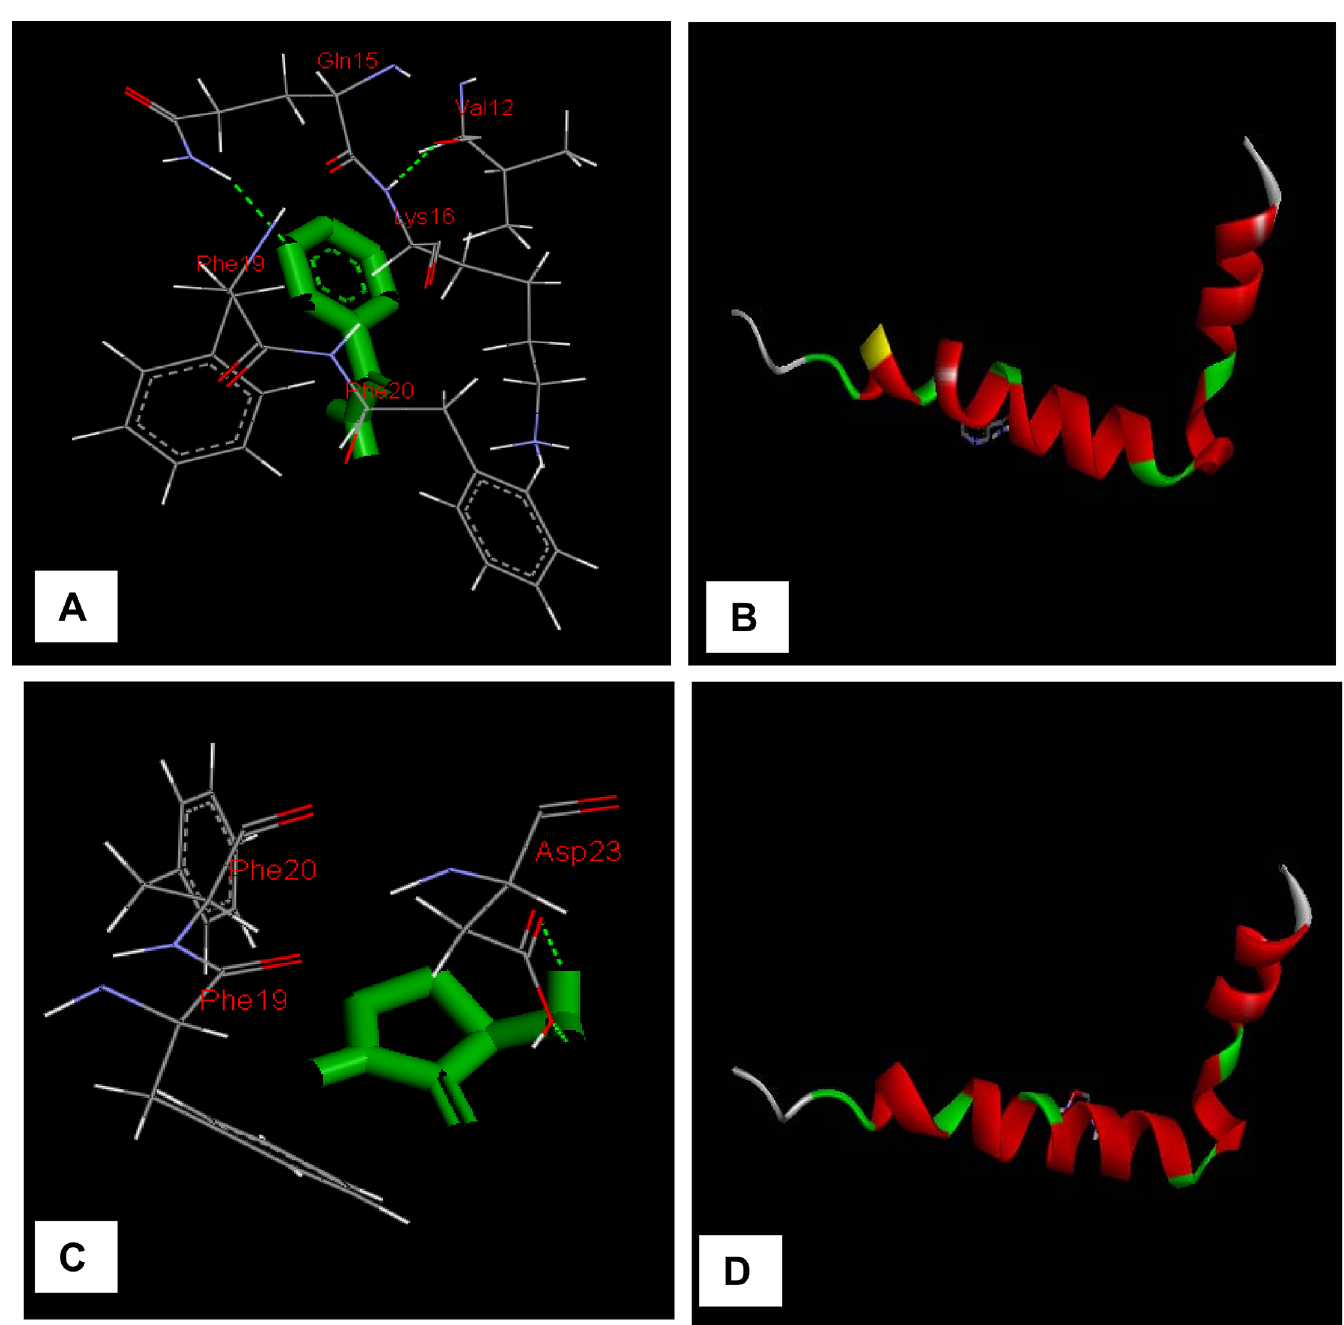
Fig 13. Detailed view of the docking poses of drug [(A, B) PYZ and (C, D) DCS]- A β -42